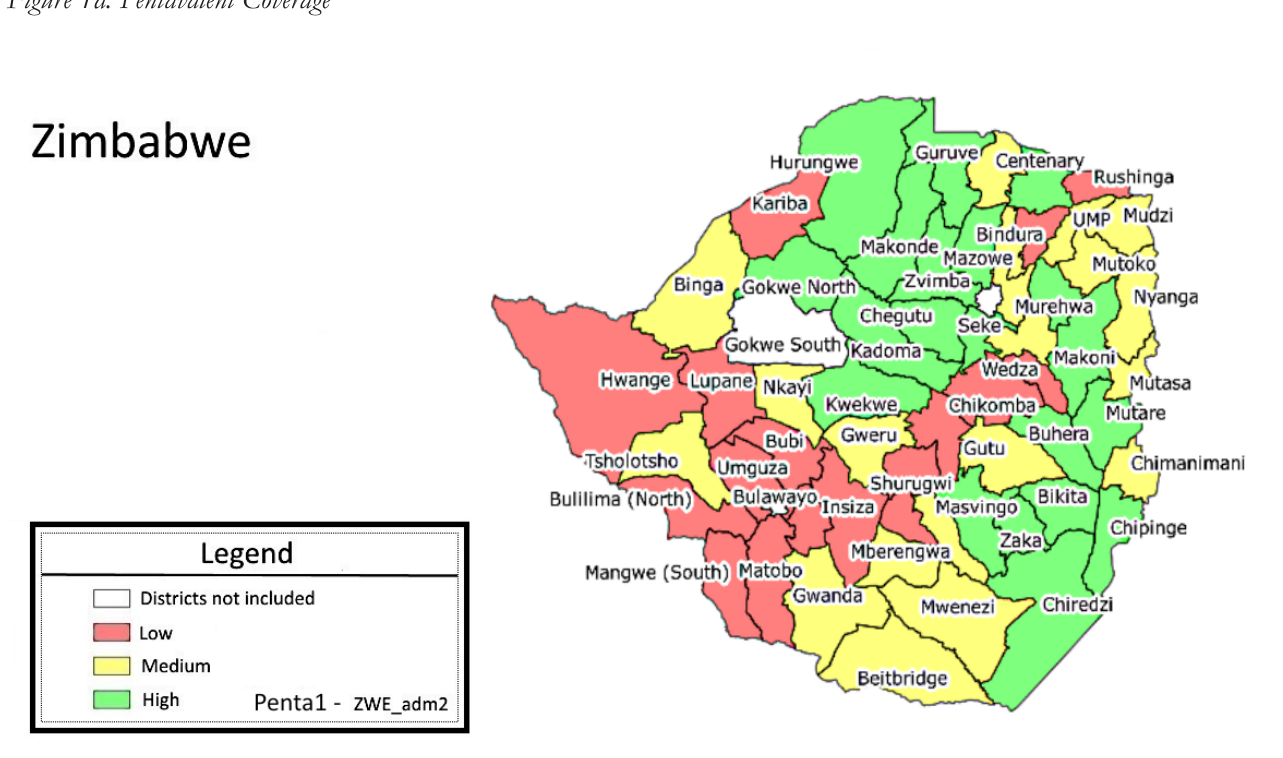
Figure 1d. Pentavalent